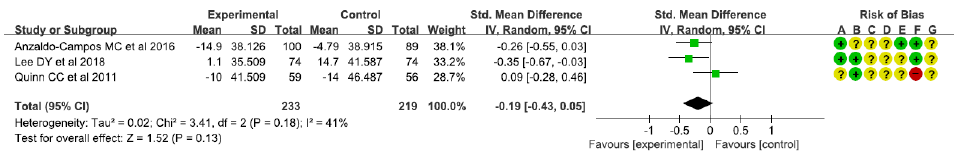
Figure 5. Forest plot for meta-analysis results on BMI [10,11,13–15].